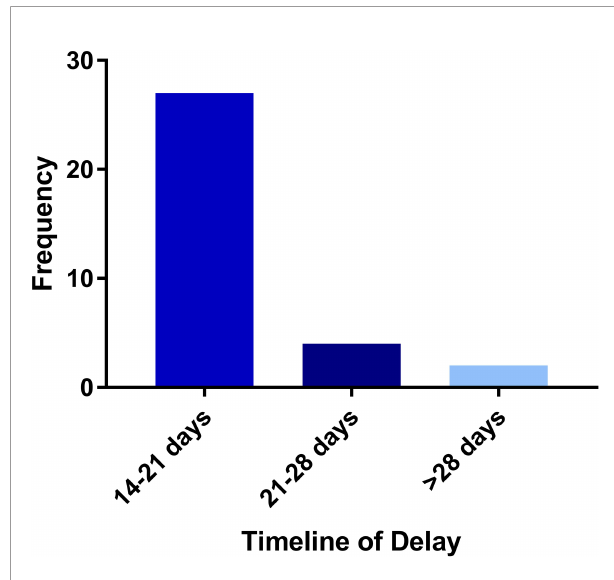
FIGURE 2 | Timeline of treatment